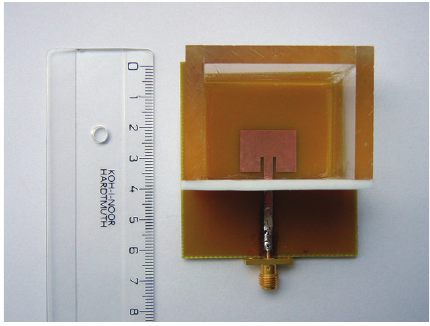
Figure 3: Photograph of the realized microwave sensor (top view).